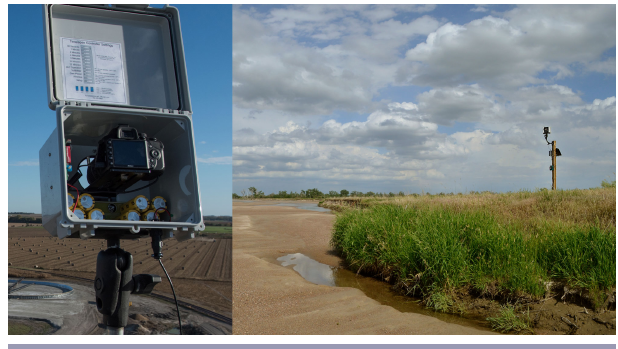
Fig. 2 . Examples of two time-lapse camera installations. On the left, a close up of the intervalometer, camera, and capacitors and on the right, an installation with solar panel and additional monitoring equipment overlooking the Platte River,